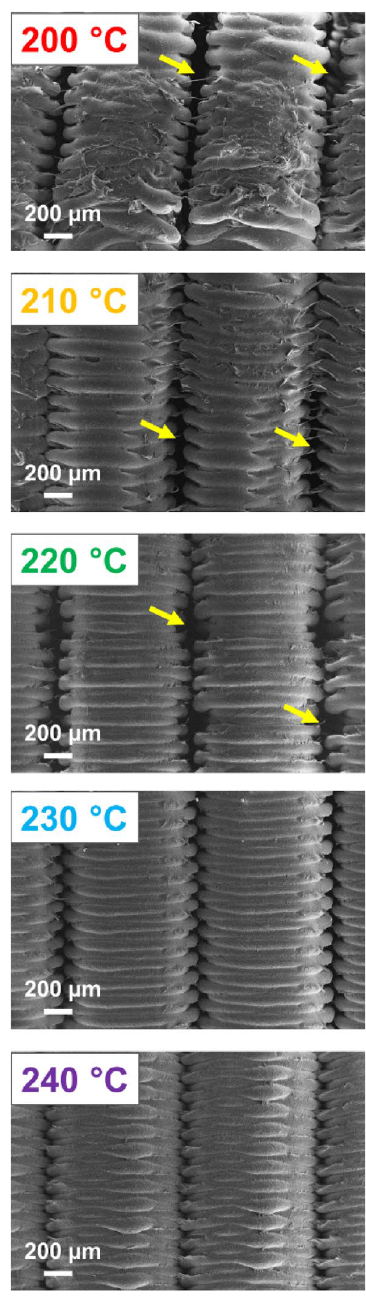
Figure 6. Scanning electron microscopy imaging of the internal cross-section of CB/PLA electrodes made at varying extruder temperatures. Arrows highlight the presence of voids between the printing layers within the electrode